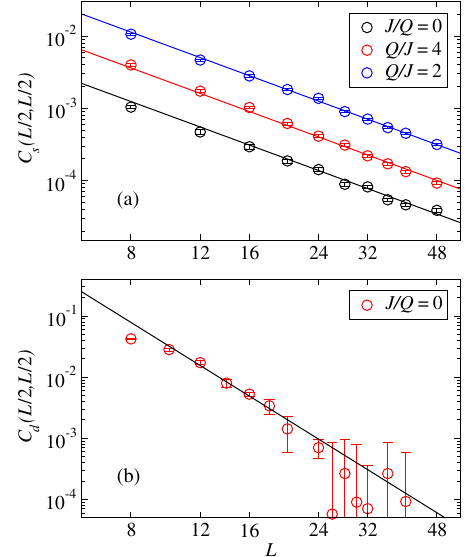
FIG. 12. Absolute values of the mean long-distance spin (a) and dimer (b) correlations at three coupling ratios inside the RS phase of the random- Q model. Results are shown at the largest distance on the periodic L × L lattices. The three lines in (a) correspond to decay of the form ∝ L − 2 , and the line in (b) shows the form ∝ L − 4 .